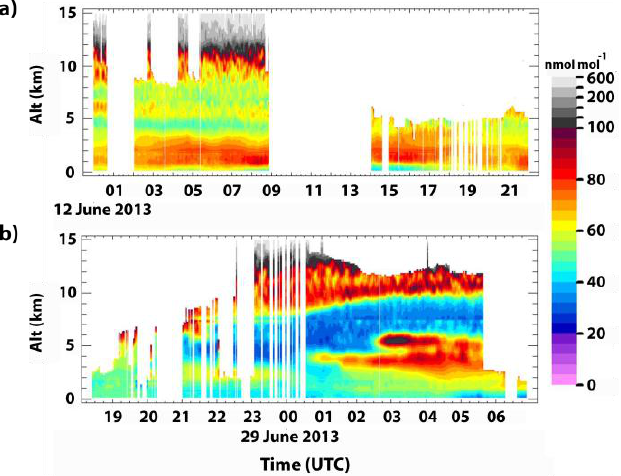
− 1 ) on ( a ) 12 June 2013 and ( b ) 28–29 June